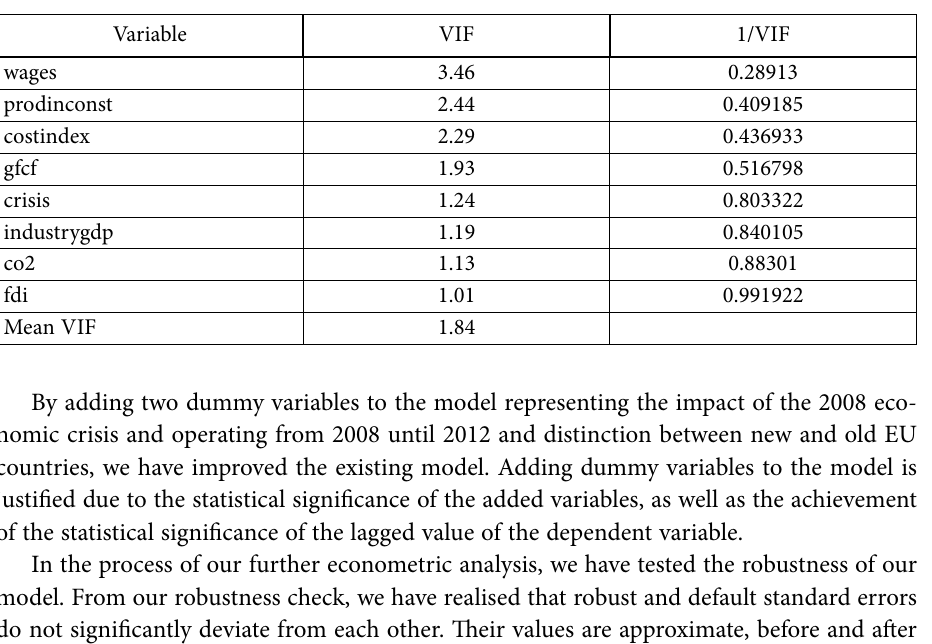
Table 3. Multicollinearity test results (source: Stata, Authors’ calculation)